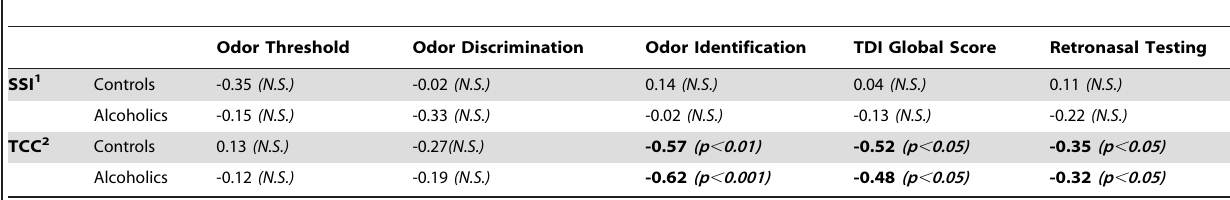
Table 3. Pearson’s correlations in both groups (N =20) between olfactory results (horizontal) and executive functions data (vertical): r value ( P-value ). Significant results are indicated in bold